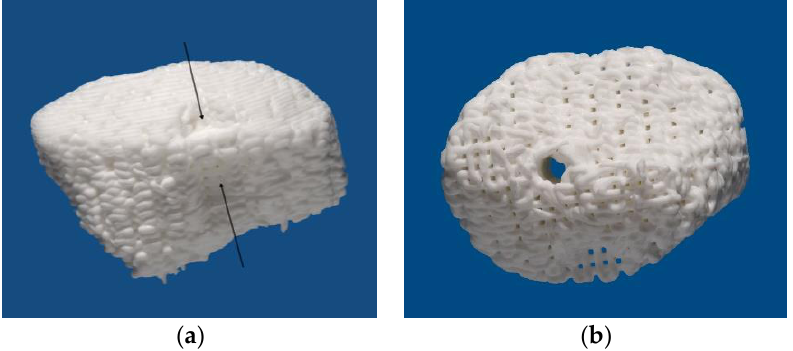
Figure 2. Scaffold for grafting the left maxillary sinus. ( a ) Lateral aspect with black arrows depicting the grooves for the tweezers. ( b ) The structure of the calcium phosphate strains and the cavity for the fixation screws are clearly visible.